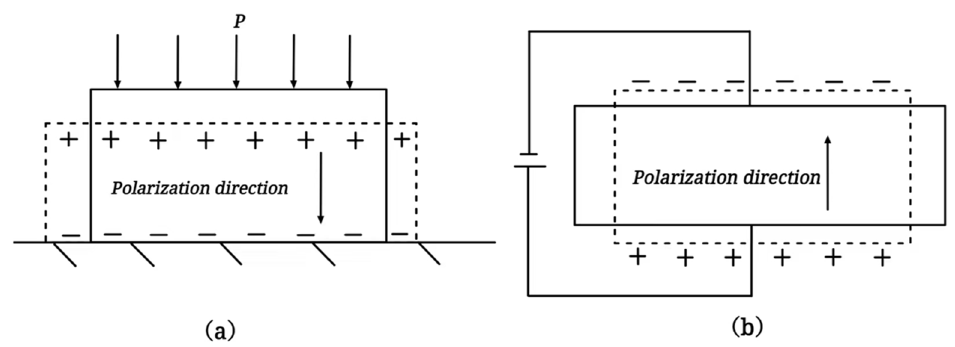
Figure 1. Schematic diagram of piezoelectric effect and polarization direction: ( a ) Direct piezoelectric effect; ( b ) inverse piezoelectric effect.